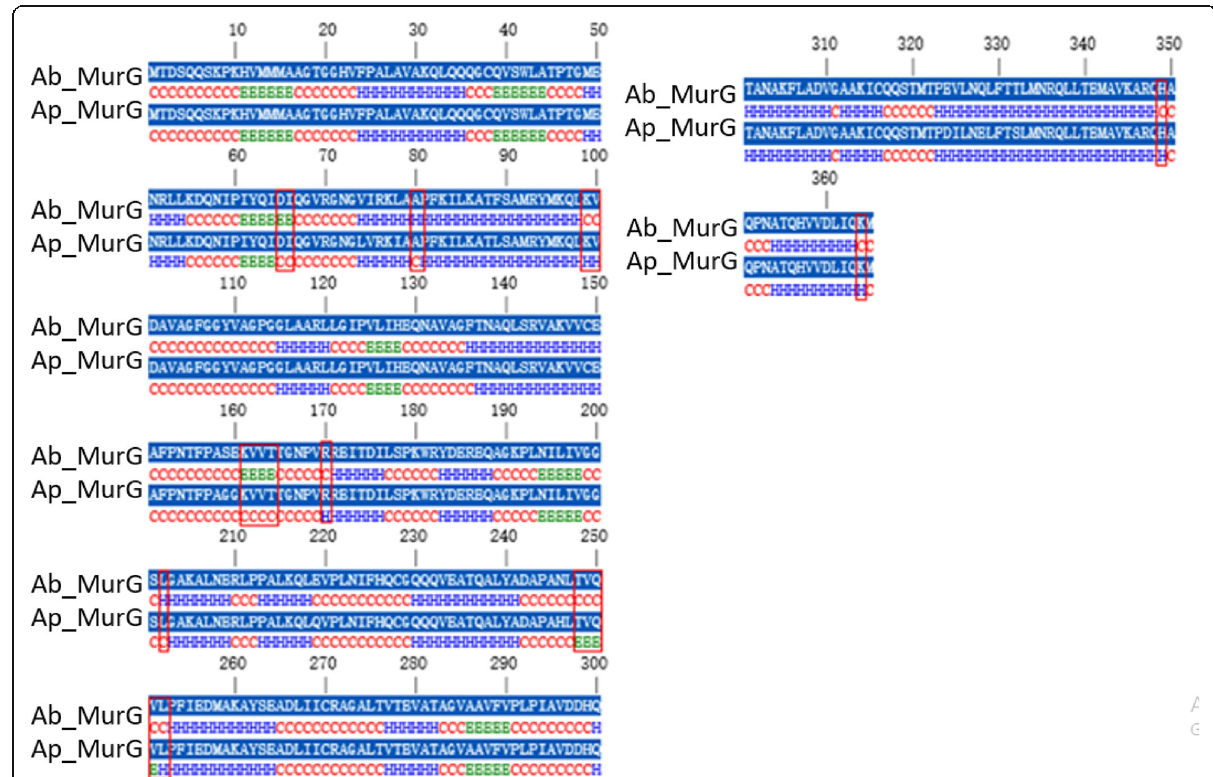
Fig. 16 Conserved secondary structure prediction and comparison of MurG from A . baumannii and A . pittii. Structurally variable regions in between them were highlighted using red boarded rectangular